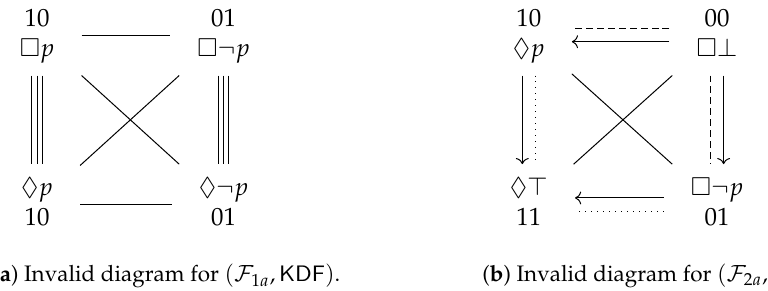
Figure 10. Invalid (!) diagrams that approximate the PCDs for ( F 1 a , KDF ) and ( F 2 a , KD )